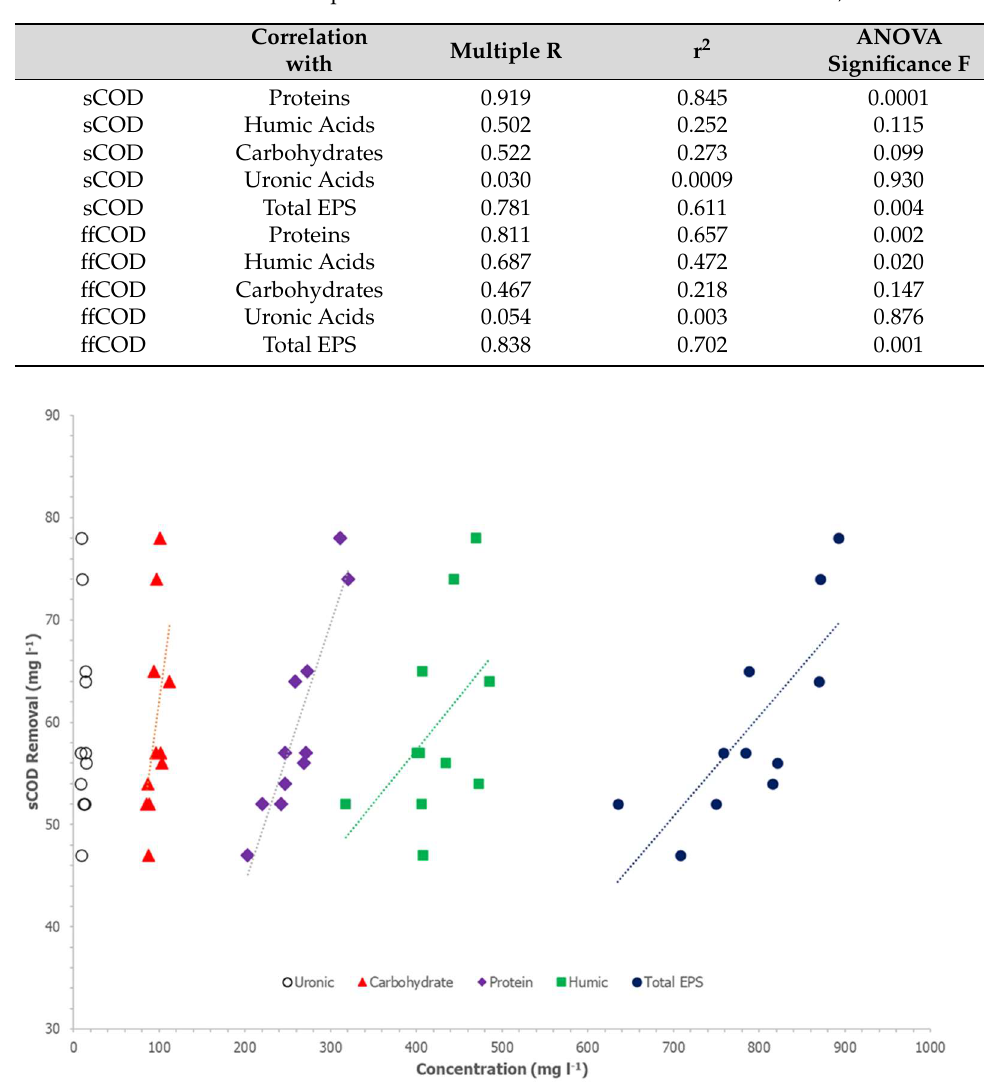
Figure 3. Biosorption of sCOD as a function of EPS Component Concentrations.